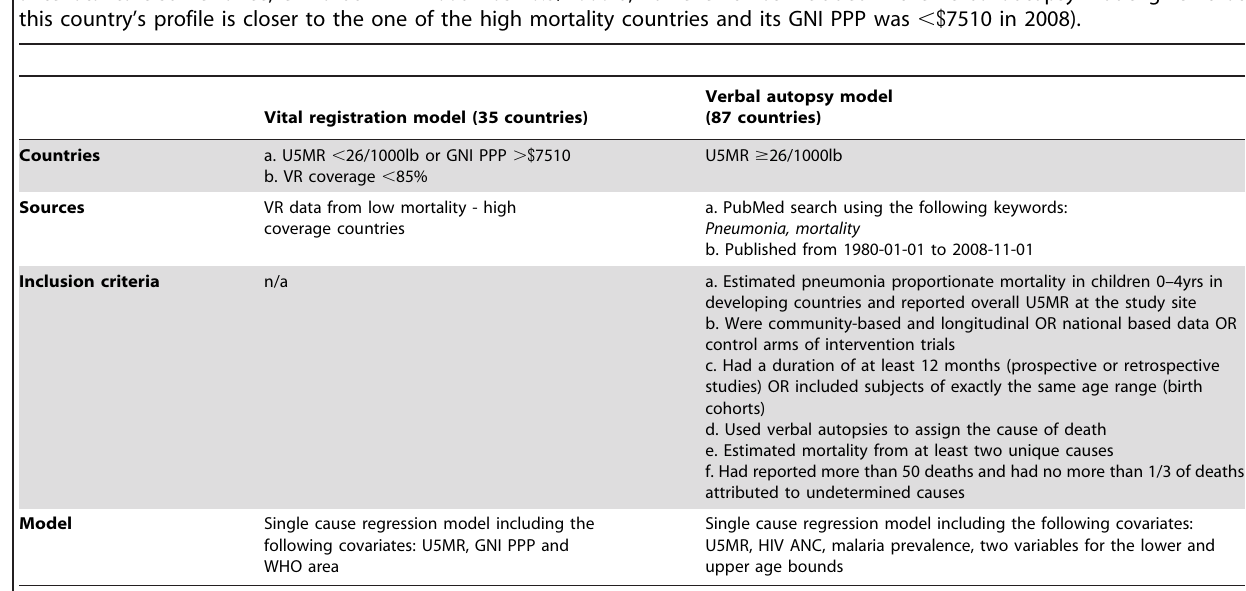
Table 1. Methods for estimating pneumonia child mortality in all countries (U5MR: under five mortality rate, GNI PPP: gross national income per capita at purchasing power parity, VR: vital registration, HIV ANC: index score for HIV prevalence based on the antenatal care surveillance; China U5MR in 2008 was 20.5/1000lb, however it was included in the Verbal autopsy model given that this country’s profile is closer to the one of the high mortality countries and its GNI PPP was , $ 7510 in